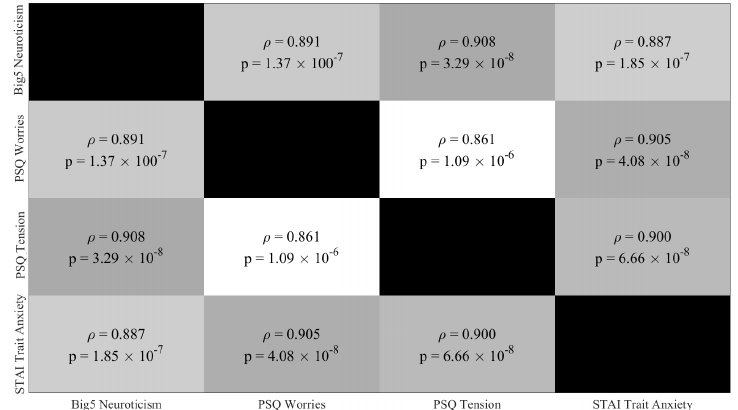
Figure A10. Paired partial (Spearman) correlations between participants’ responses to neuroticism (NEO-FFI), worries (PSQ), tension (PSQ), and trait anxiety (STAI-G-X2). This figure verifies that the participants’ responses to these questionnaires showed strong correlations which were calculated by regressing out the potential effect of responses to other questionnaires while calculating every-pair correlations (e.g., regressing out the neuroticism and trait anxiety while computing the correlation between worries and tension).